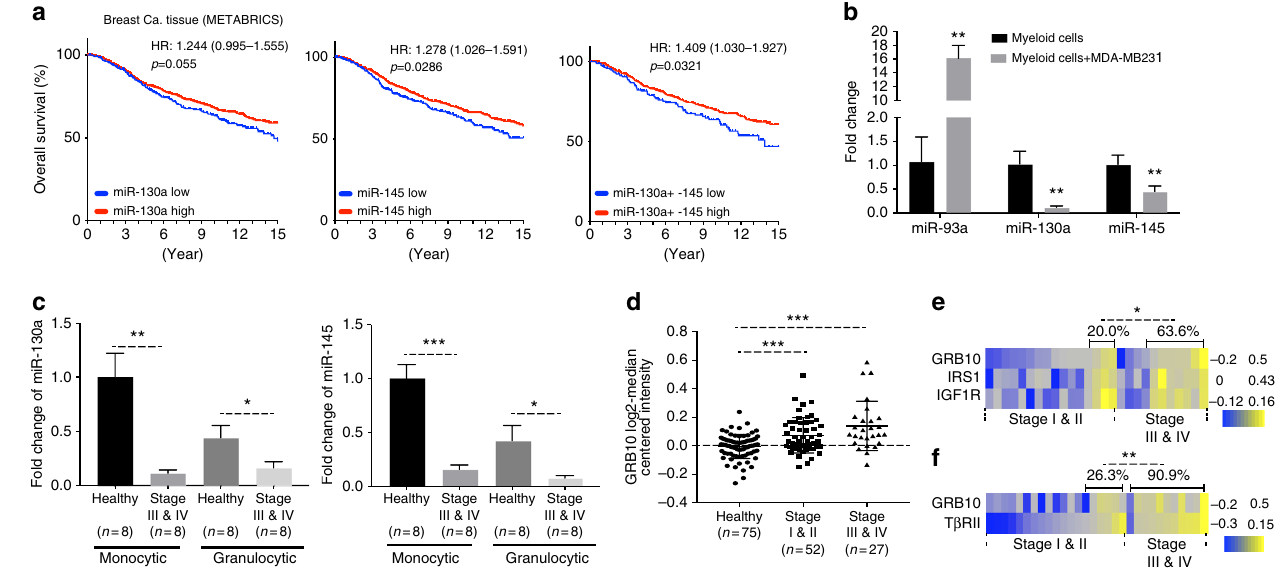
Fig. 6 miR-130a and miR-145 targeted genes and correlation with human cancer. a Kaplan – Meier survival curve (METABRICS data) for breast cancer patients with high & low levels of miR-130a (left), miR-145 (middle), and both miR-130a and 145 (right) in tumor tissues. Log-rank test was used to analyze the survival data. HR hazard ratio with its 95% con fi dence interval. b Fold change of miR-130a and miR-145 expression in human immature myeloid cells co-cultured with human breast cancer cell line MDA-MB231, miR-93 as a positive control. c qRT-PCR for fold changes of miR-130a (left) and miR-145 (right) in sorted human monocytic and granulocytic subsets from peripheral blood of healthy donors ( n = 8) or patients with advanced GI cancer ( n = 8). d Correlation of GRB10 levels in human peripheral blood mononuclear cells (PBMCs) (GSE20189) with human lung cancer stages. e Heat map showing a correlation of three key IGF pathway mediators (IGF1R, GRB10, and IRS1) with stages of human lung cancer (GSE20189). f Correlation of GRB10 and T β RII expression levels (key mediators of both IGF and TGF β pathways) with stages of human lung cancers (GSE20189). Yellow and blue colors indicate increased and decreased expression, respectively. The data were plotted with patients divided into stage I/II vs III /IV groups. The percentage of patients with higher expression level was calculated for each group as indicated. The data are represented as mean ± SEM, and Student ’ s t test or χ 2 -square test in ( e , f ) was performed * p < 0.05, ** p < 0.01, *** p <